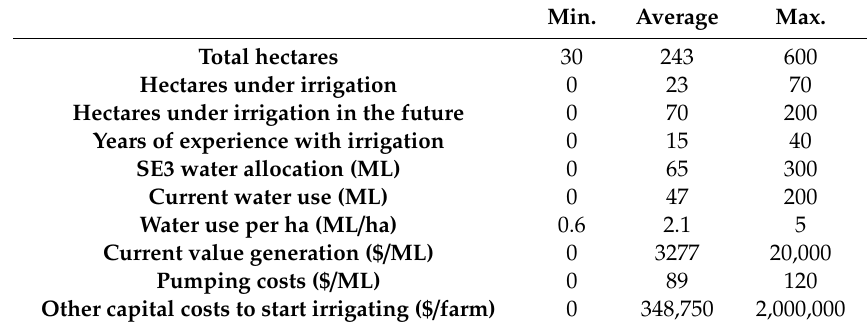
Table 1. Interview findings on farm characteristics, including water use and additional costs for irrigation. Min.